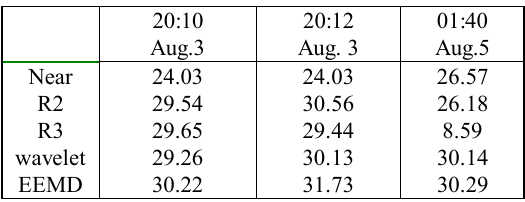
Table 1. SNR of different denoising